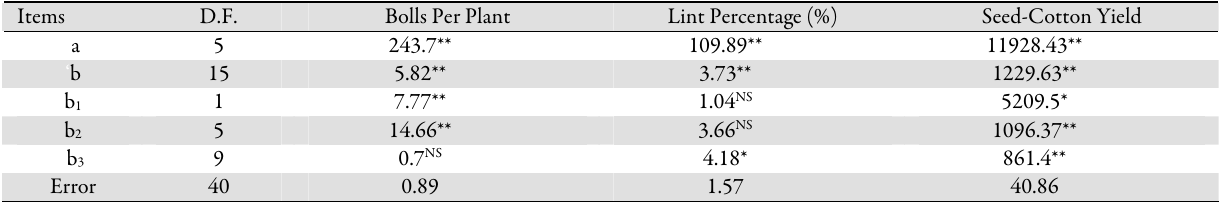
Table 4. The diallel analysis of variance of the F 1 crosses Items